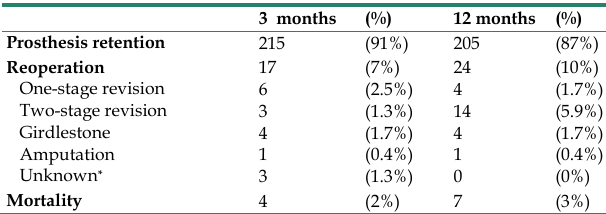
Table 4. Outcome following DAIR and